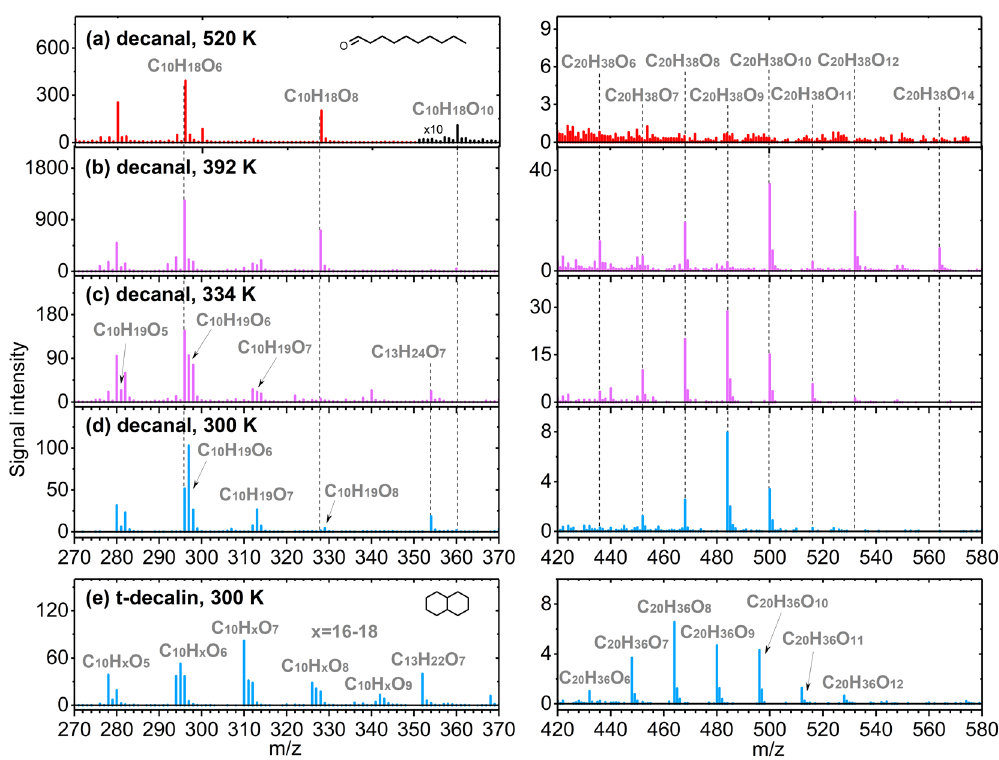
Fig. 2 Product species distribution from the autoxidation of VOCs as measured by mass spectrometry. The mass spectra for decanal are in ( a – d ) and the mass spectrum for trans-decalin is in ( e ). The left and right panels cover the mass ranges of monomer and ROOR accretion products, respectively. TME + O 3 reactions were used to produce OH radicals needed to initiate VOC oxidation in all experiments, except at T = 520 K, where oxidation was initiated by O 2 . C 13 products result from accretion between TME derived C 3 _RO 2 and decalin/decanal derived C 10 _RO 2 . Spectra in a – c were measured from the JSR, d – e from the Helsinki fl ow reactor.